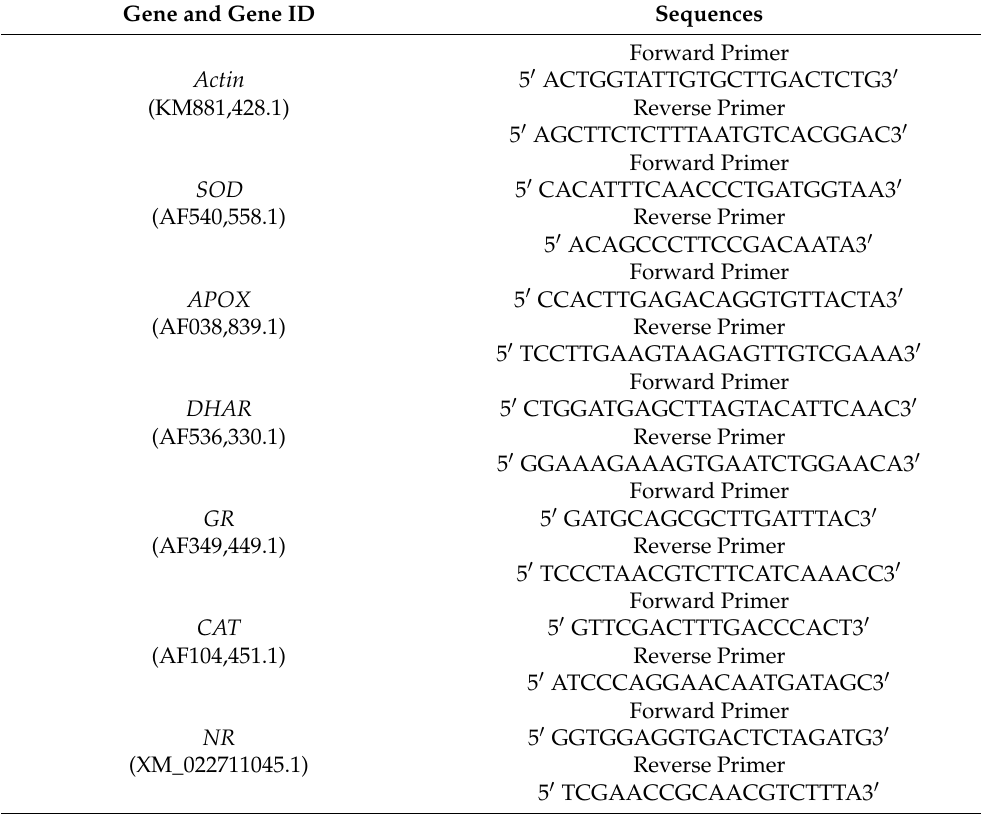
Table 1. Primer sequences of various genes for qRT-PCR in the present